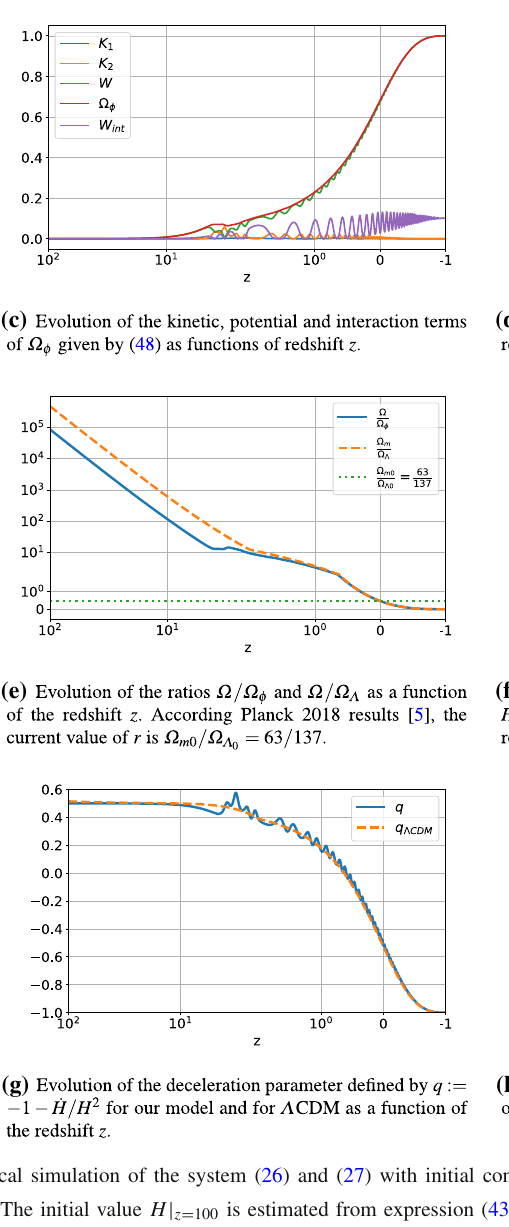
z = 100 is estimated from expression (43). The exact solutions for the